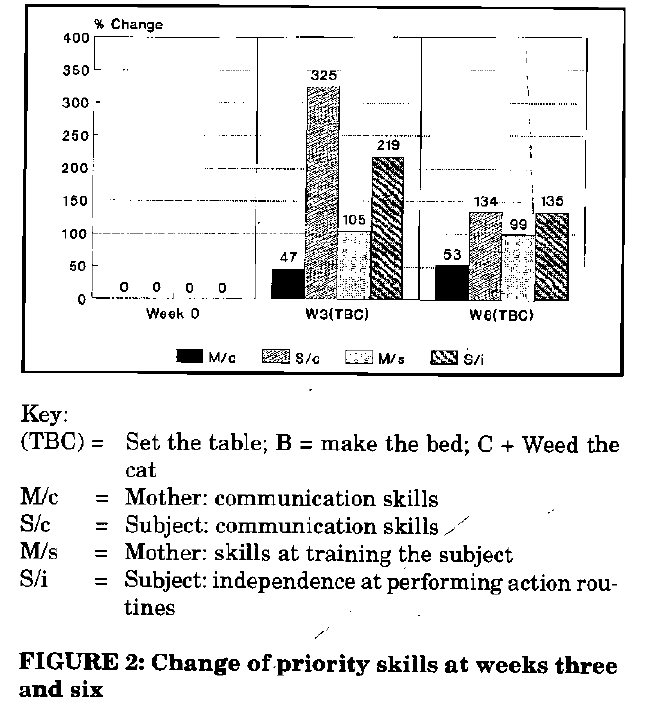
FIGURE 2: Change of priority skills at weeks three and